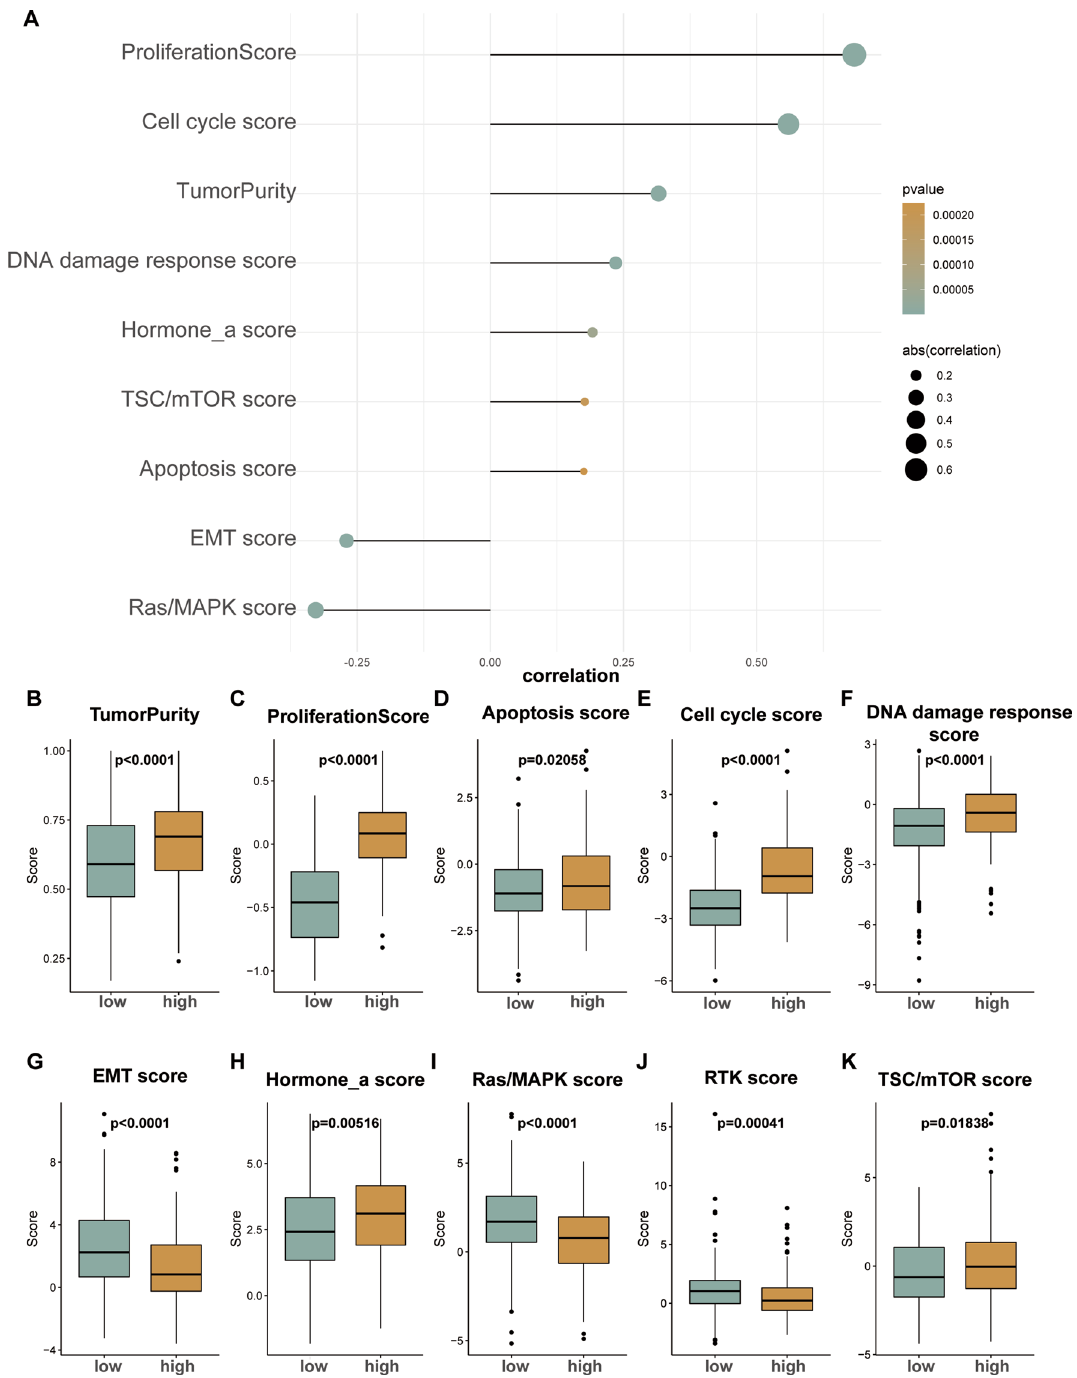
Figure 8. Phenotype heterogeneity among the network-based subtypes. The bubble map shows the correlation between the ferroptosis-related risk score and RPPA data-based scores ( A ). Boxplots show differences